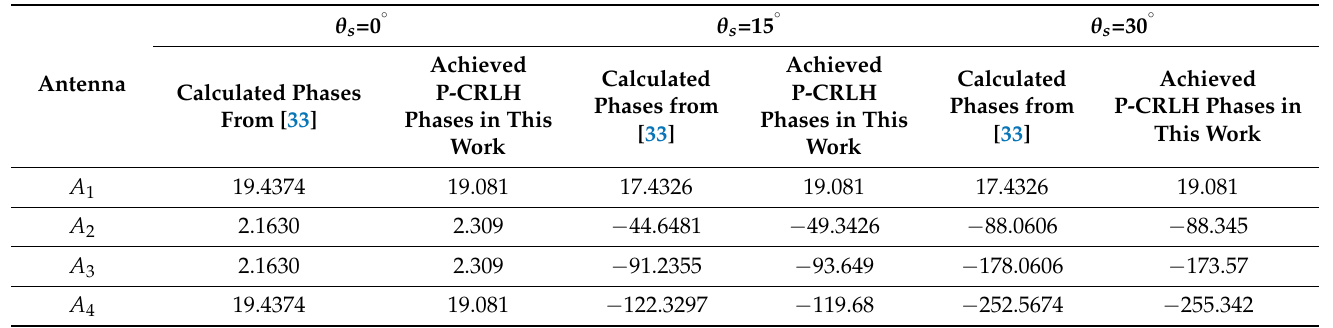
Table 1. Phases (degrees) for broadside, 15, ◦ and 30 ◦ main-beam scanning of a cylinder with r = 30